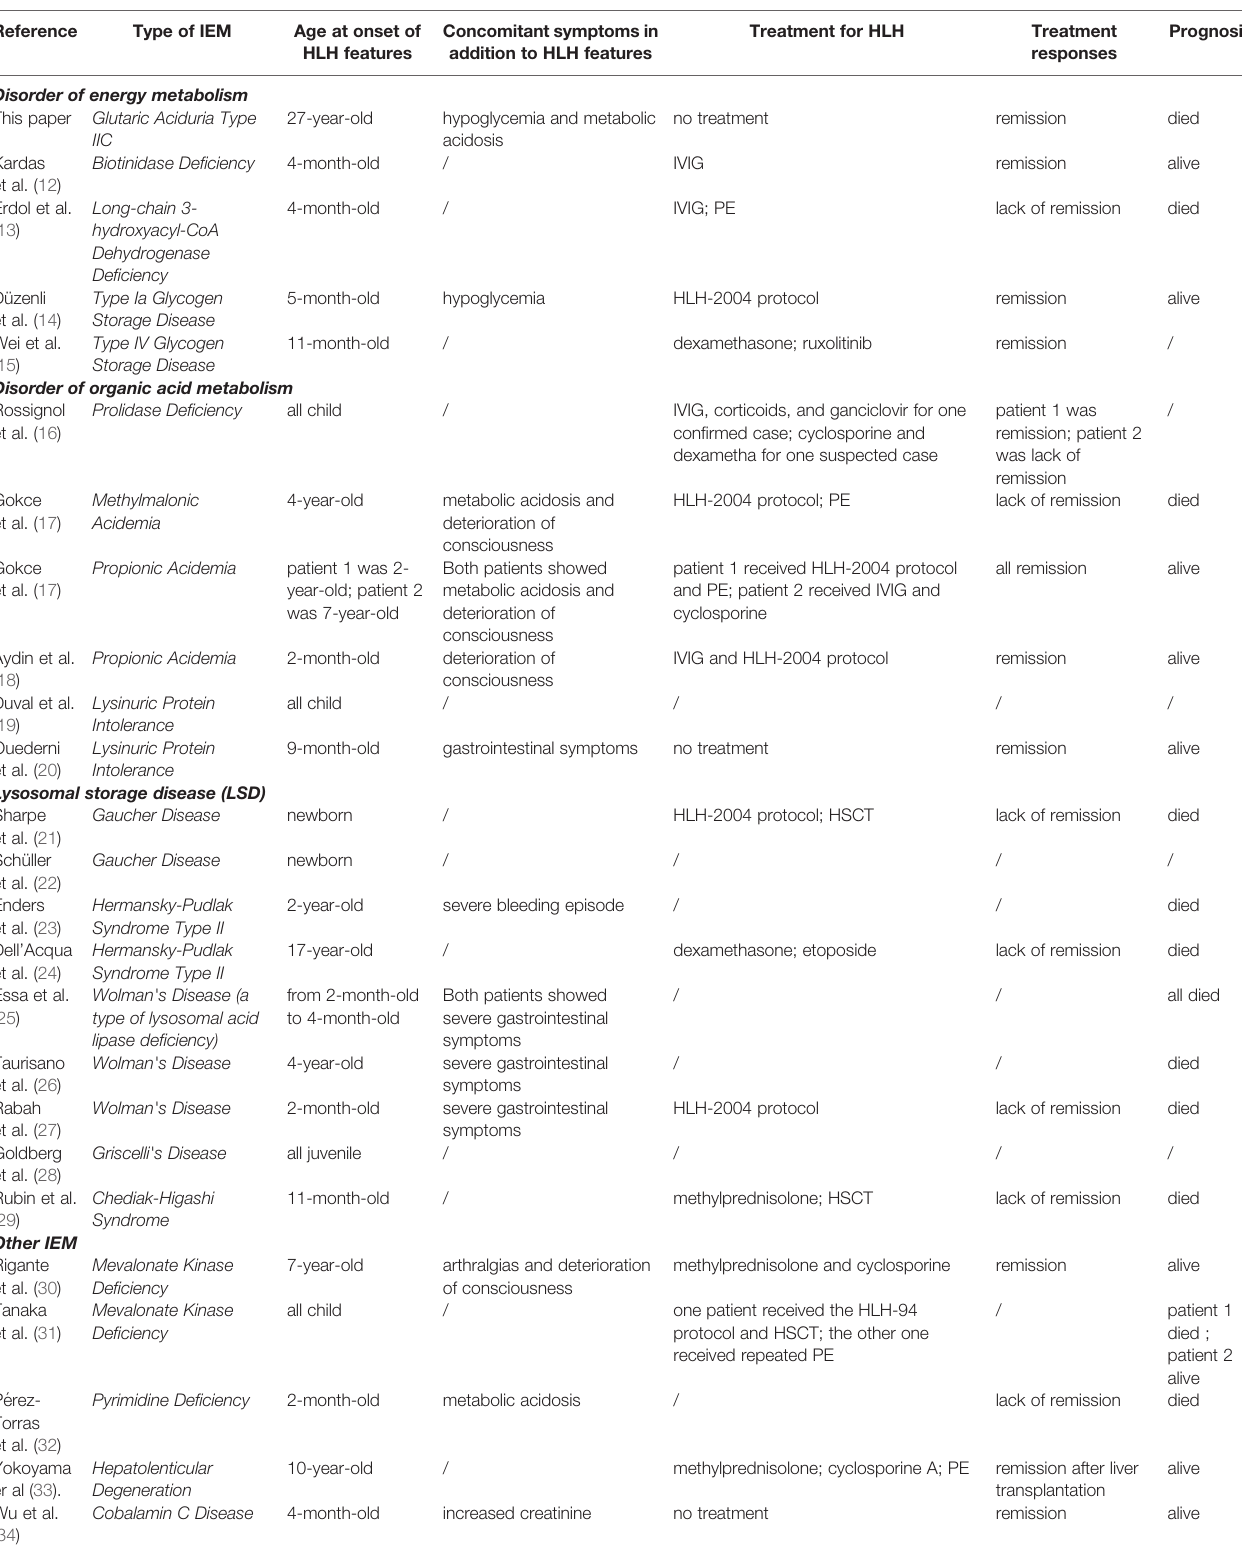
TABLE 2 | Reported cases of IEM complicated by